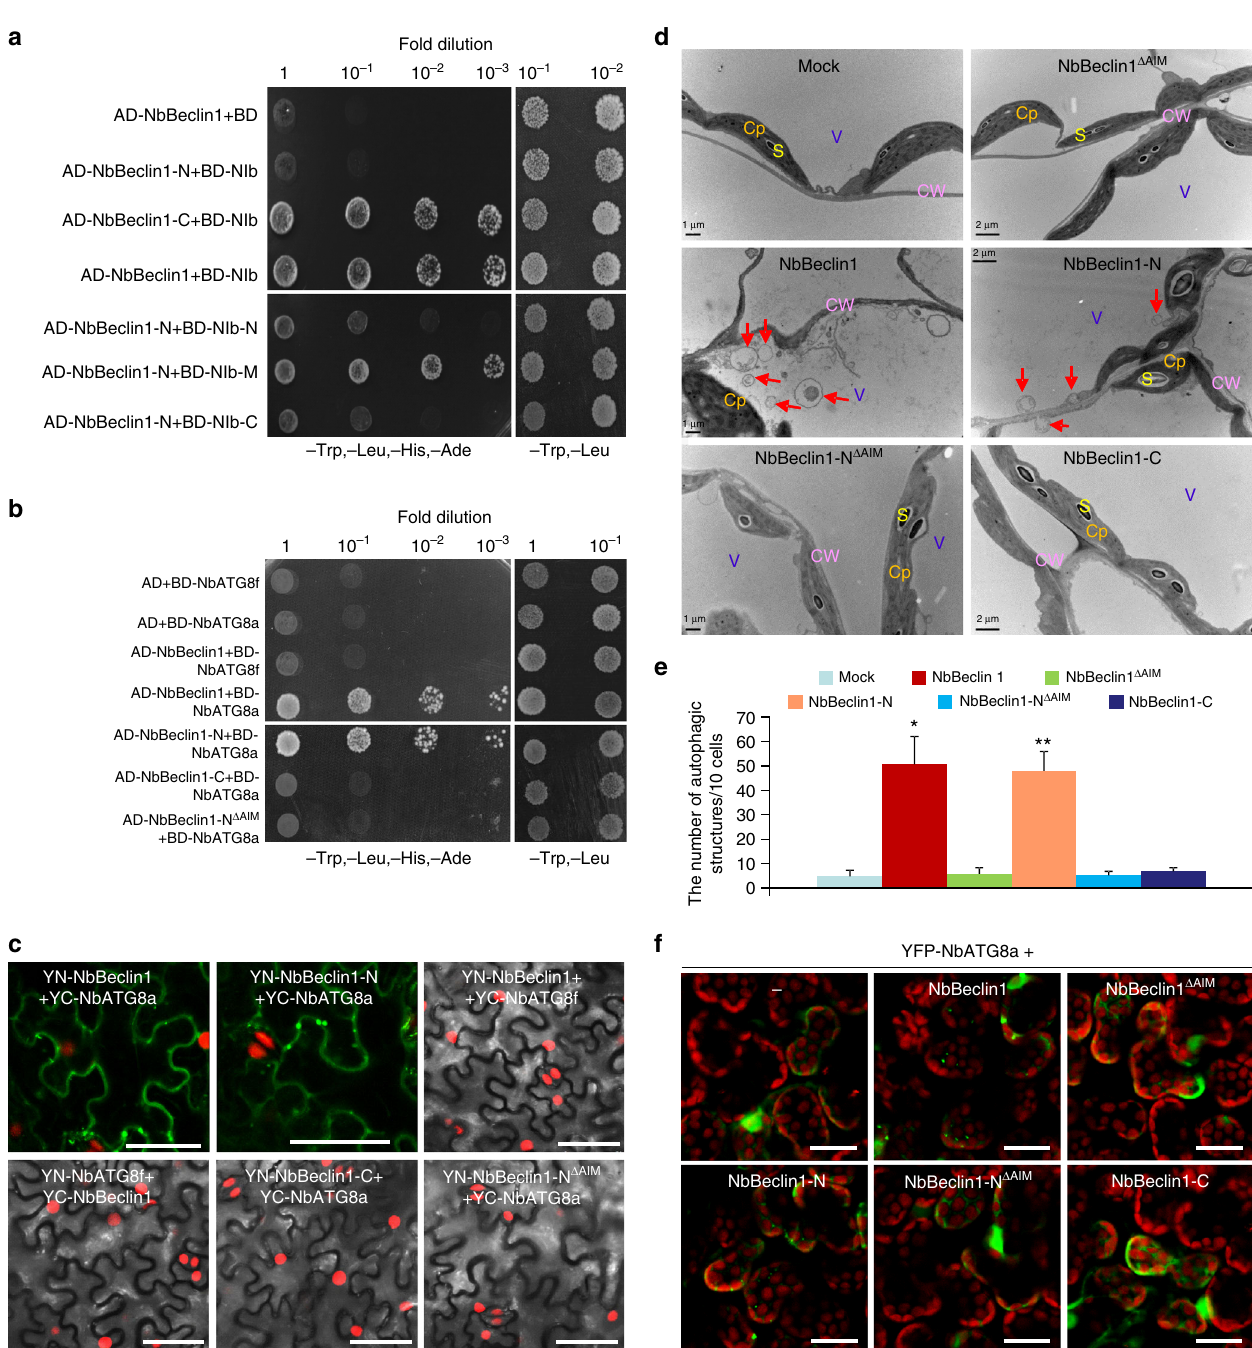
Fig. 6 The GDD motif of NIb is required for the NbBeclin1 – NIb interaction and NbBeclin1, via its AIM, interacts with NbATG8a to facilitate the formation of autophagosomes. a Y2H assays to detect possible interactions between NbBeclin1 truncated proteins (NbBeclin1-N and NbBeclin1-C) and NIb and between NbBeclin1 and NIb truncated proteins (NIb-N, NIb-M, and NIb-C). b Y2H assays to detect possible interactions between NbBeclin1 and NbATG8f or NbATG8a and between NbATG8a and NbBeclin1-N, NbBeclin1-C, or NbBeclin1-N AIM mutant (NbBeclin1- N Δ AIM ). c BiFC assays in H2B-RFP (red) transgenic N . benthamiana leaves at 48 hpi. Yellow fl uorescence (green) was observed as a consequence of the complementation of the YN and YC tagged with NbBeclin1 and NbATG8a or NbBeclin1-N and NbATG8a. Bars, 50 μ m. d Representative TEM images from N . benthamiana leaf cells agroin fi ltrated with buffer (mock), NbBeclin1, NbBeclin1 Δ AIM , NbBeclin1-N, NbBeclin1-N Δ AIM , or NbBeclin1-C at 60 hpi. Typical autophagic structures (red arrows) were observed in NbBeclin1- or NbBeclin1-N-expressing leaves in the cytoplasm. Cp chloroplast, CW cell wall, S starch, V vacuole. Bars mean 1 μ m or 2 μ m as indicated. e The number of typical double-membrane autophagic structures in mock, NbBeclin1-, NbBeclin1 Δ AIM -, NbBeclin1-N-, NbBeclin1-N Δ AIM -, or NbBeclin1-C-in fi ltrated leaves. Experiments were repeated three times and typical autophagic structures were counted in 20 cells in each treatment. Values represent the mean number of autophagosomes ±SD per 10 cells. Single asterisk indicates statistically signi fi cant difference ( P < 0.05) between mock and NbBeclin1-in fi ltrated leaves, and double asterisks indicate P < 0.01 between mock and NbBeclin1-N (Student ’ s t -test, two-sided). f Confocal micrographs showing N . benthamiana leaf cells co-in fi ltrated with Agrobacterium harboring a YFP-NbATG8a expression construct and Agrobacterium carrying NbBeclin1, NbBeclin1 Δ AIM , NbBeclin1-N, NbBeclin1-N Δ AIM or NbBeclin1-C at 48 hpi. Bars, 25 μ